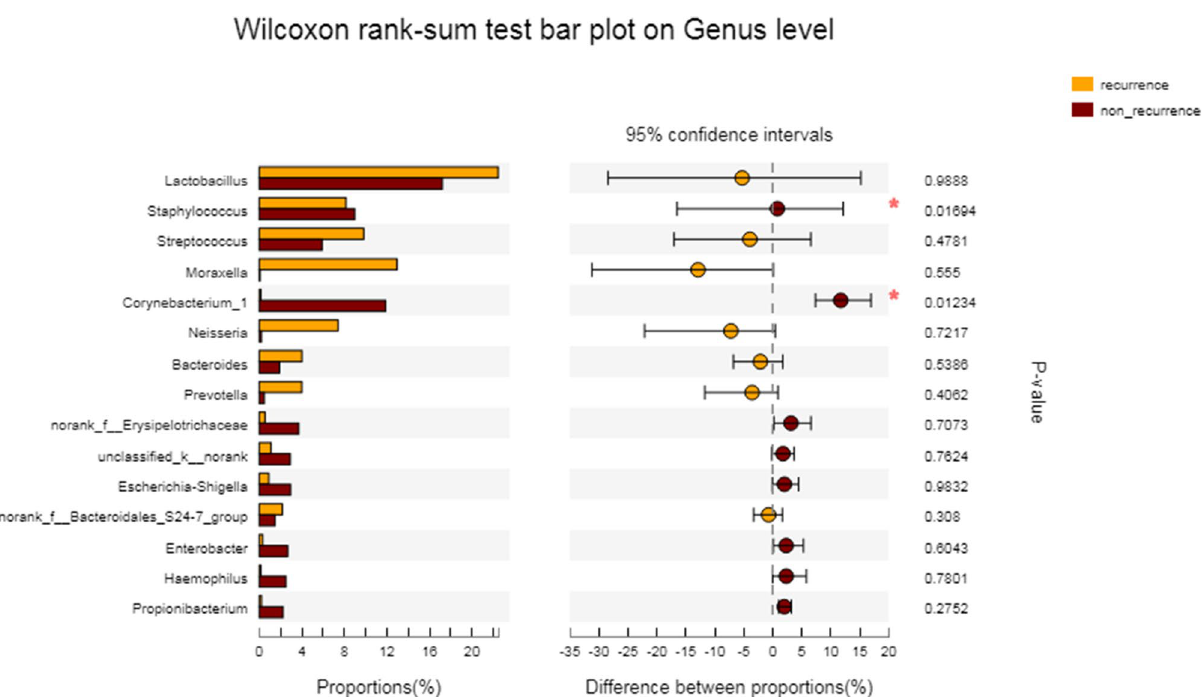
Figure 5. The Wilcoxon rank sum test was used to compare the difference in nasal microbial colony composition between recurrent and non-recurrent nasal polyp patients at the general